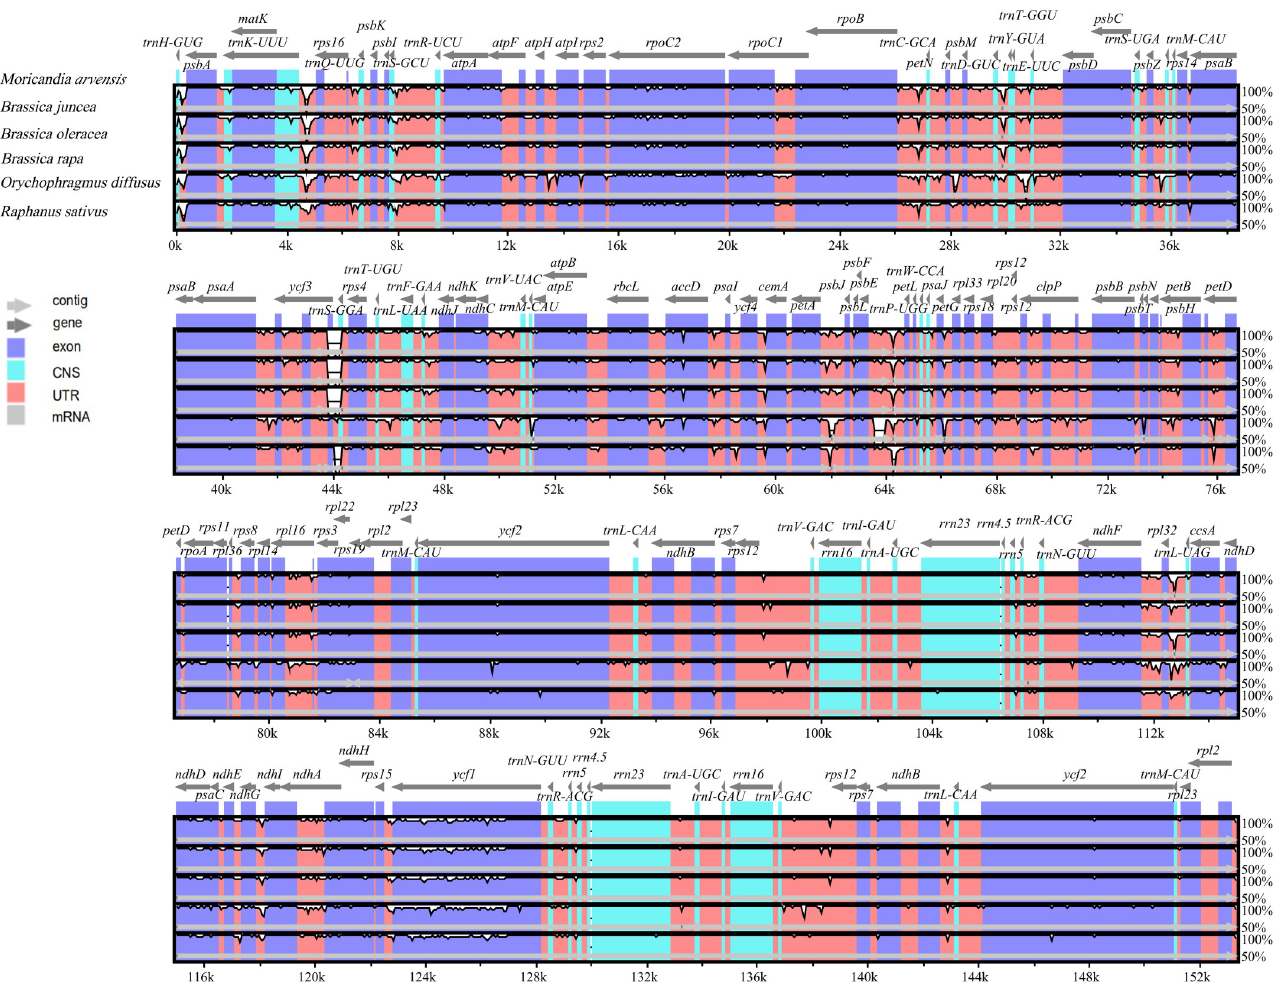
Fig 2. Alignment of the cp genomes of M . arvensis and five closely related species. The alignment was performed by mVISTA with M . arvensis as the reference. Local collinear blocks within each alignment are indicated by the same color and